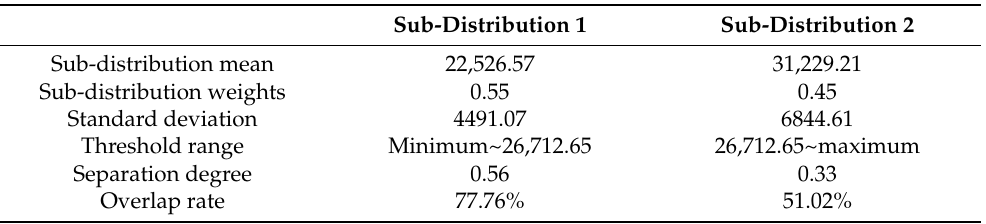
Table 5. Parameter values of each sub-distribution of the improved mixed monolithic sieving model for image C.